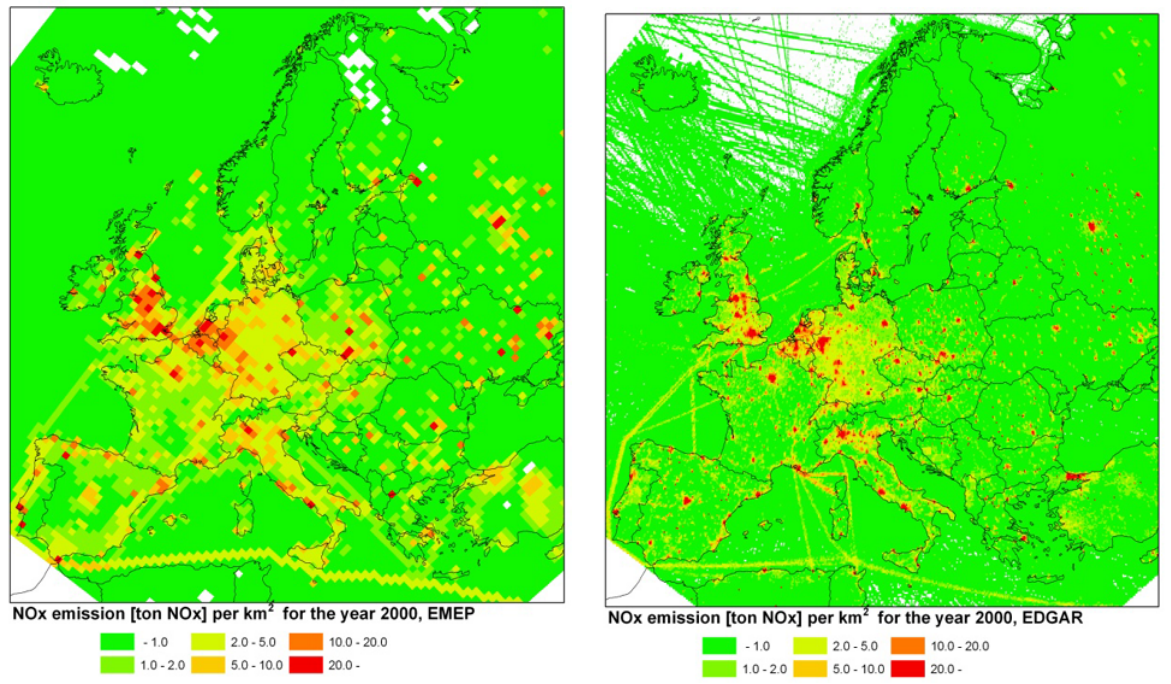
Fig. 6. Spatial distributions of annual NO x emissions in Europe for the year 2000 based on: (left) EMEP at 50km × 50km to the (right) EDGAR at 0.1 ◦ × 0.1 ◦